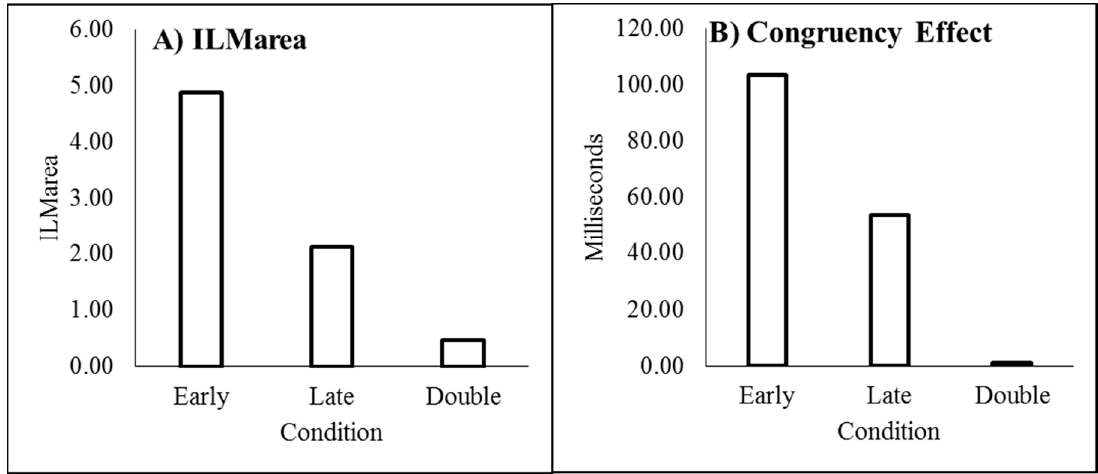
Figure 6. Mean A ) ILM area and B ) decision time congruency effect from Experiment 2 for the early, Figure 6. Mean ( A ) ILM area and ( B ) decision time congruency effect from Experiment 2 for the early, late, and double change conditions. late, and double change